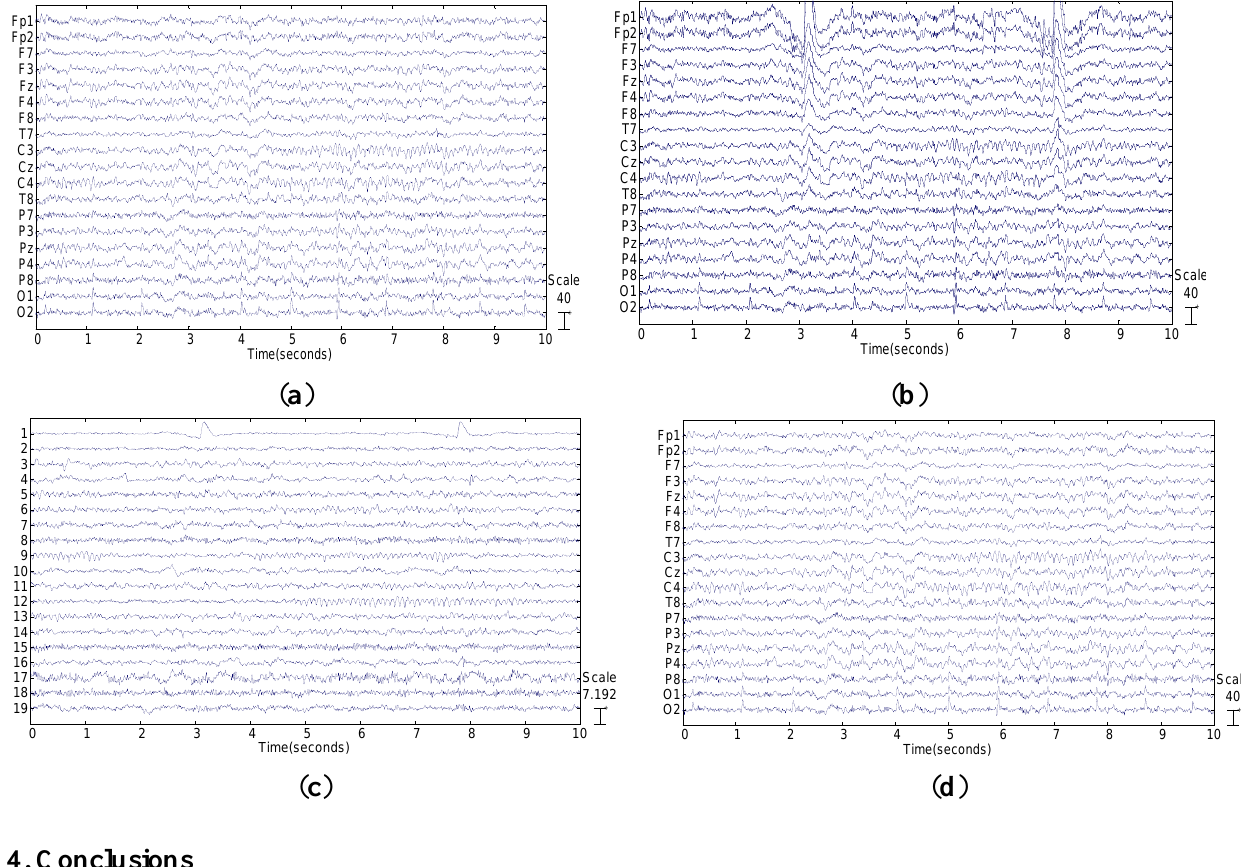
Figure 8. ( a ) An epoch of clean EEG with 19 channels; ( b ) Mixed EEG with blink contaminated, its SNR is 0.3970 ; ( c ) Independent components of mixed EEG. The first component is eye blink; ( d ) Corrected EEG by our method, its SNR is 17.6473